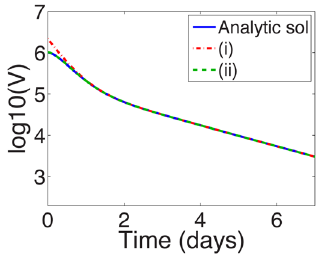
Figure 7. Truncated series solutions for the VE model compared with the exact solution (11) under silibinin treat- ment ( n w 1 ; see Table 1 for parameters). Legend: (i) Series terms with exponents { d , { d { k , { c , and { c { k terms, included in the approximation (16), from the series solution (19); (ii) Series terms with exponents from (i) and also the { d { 2 k and { d { 3 k terms missing from the approximation.